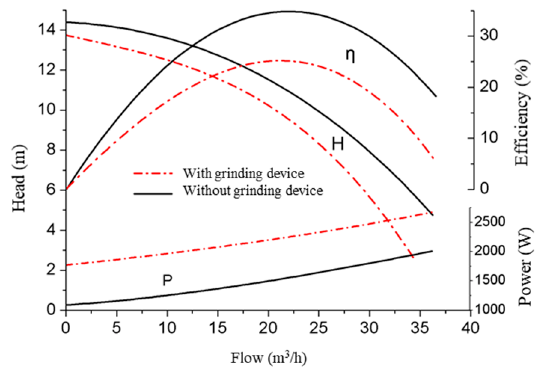
Figure 10. The effect of the grinding device on the performance of the grinding